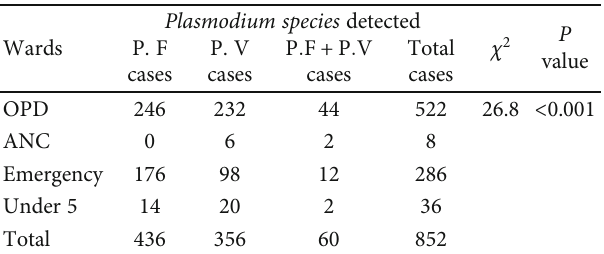
Table 4: Malaria cases among wards in Bichena Primary Hospital from 2015 to 2019. Plasmodium species Wards